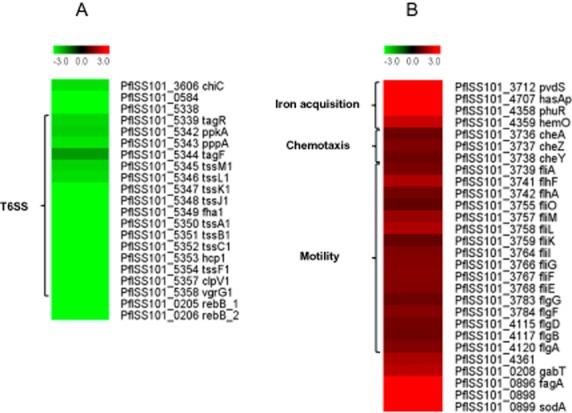
Whole genome transcriptome analysis of P. fluorescens SS101 and the ΔrsmYZ mutant. Heat maps showing significant log2-fold changes (P < 0.001) in the expression of genes in the ΔrsmYZ versus wild-type cells. Wild-type SS101 and the ΔrsmYZ mutant were grown in liquid KB at 25°C to an optical cell density of OD600 = 0.6. The fold changes shown here represent averages of three biological replicates. A represents known genes that were downregulated in the ΔrsmYZ mutant, whereas B represents known genes upregulated in the ΔrsmYZ mutant versus wild-type SS101. For a list of all genes differentially regulated in the ΔrsmYZ mutant versus wild-type SS101, we refer to Tables S2 and S3.